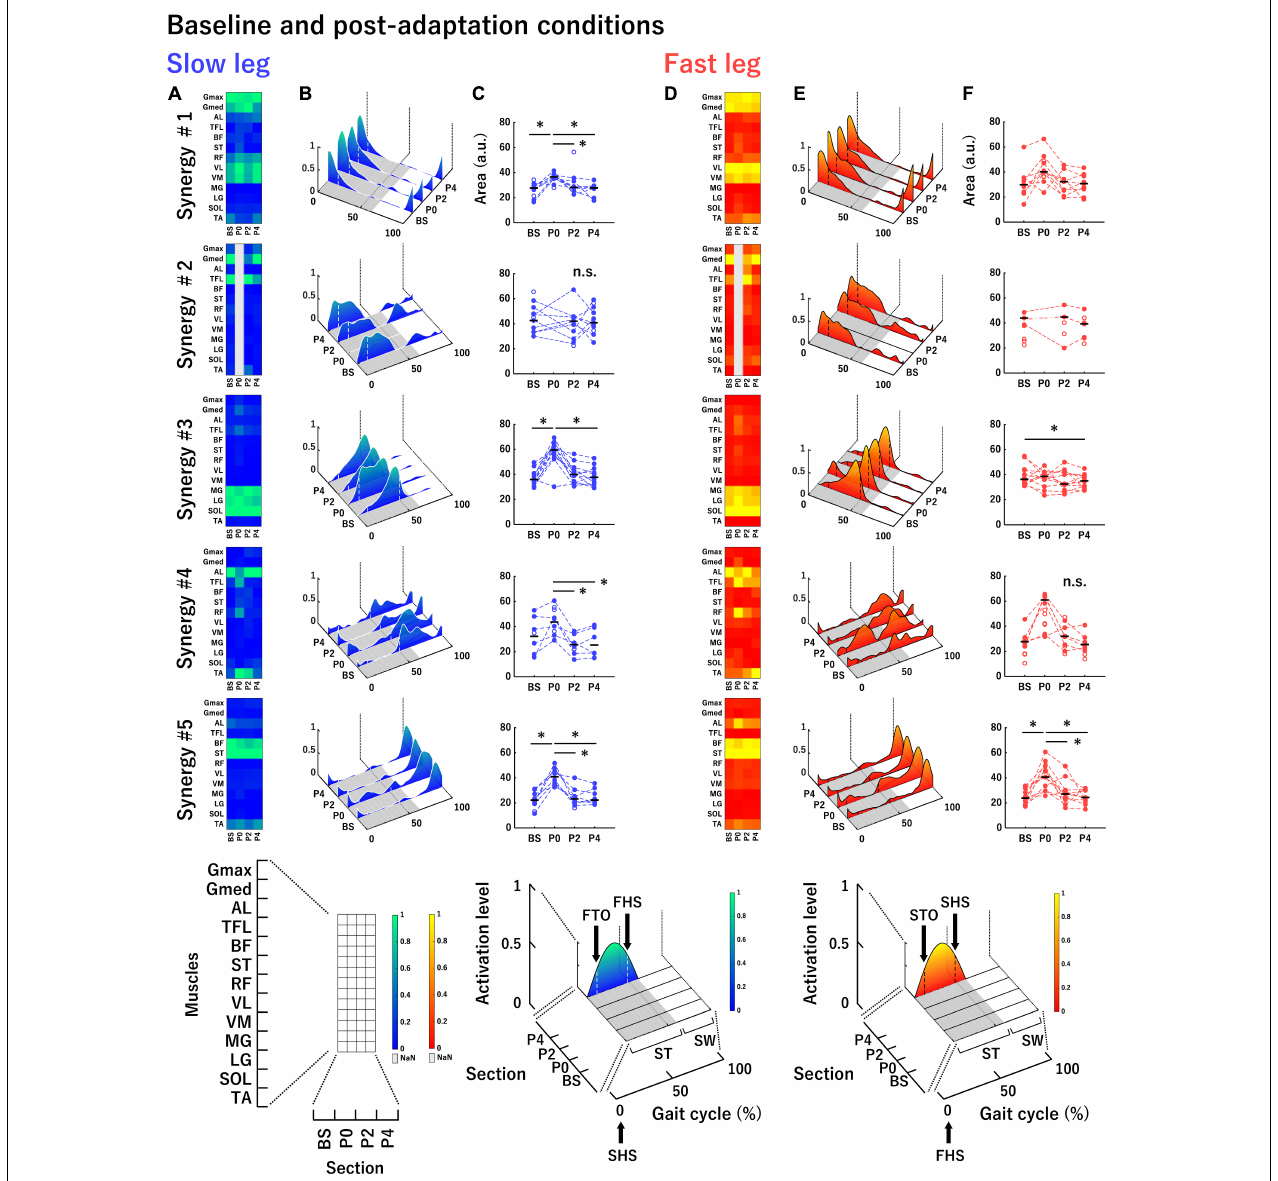
FIGURE 5 | Average muscle synergies across participants in the slow leg (A–C) and the fast leg (D–F) at each section in the baseline and post-adaptation conditions. (A,D) Each heatmap represents the muscle weighting of muscle synergies. (B,E) Each waveform represents the temporal activation patterns of muscle synergies. (C,F) The areas under the curves of temporal activation patterns of muscle synergies. The conventions of each panel are the same as those in Figure 4 . ∗ P <